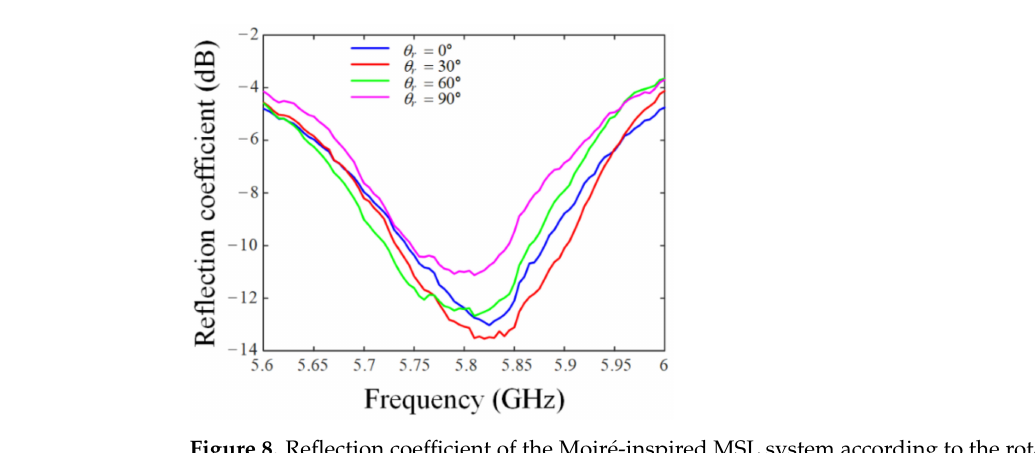
Figure 8. Reflection coefficient of the Moir é -inspired MSL system according to the rotation angle.